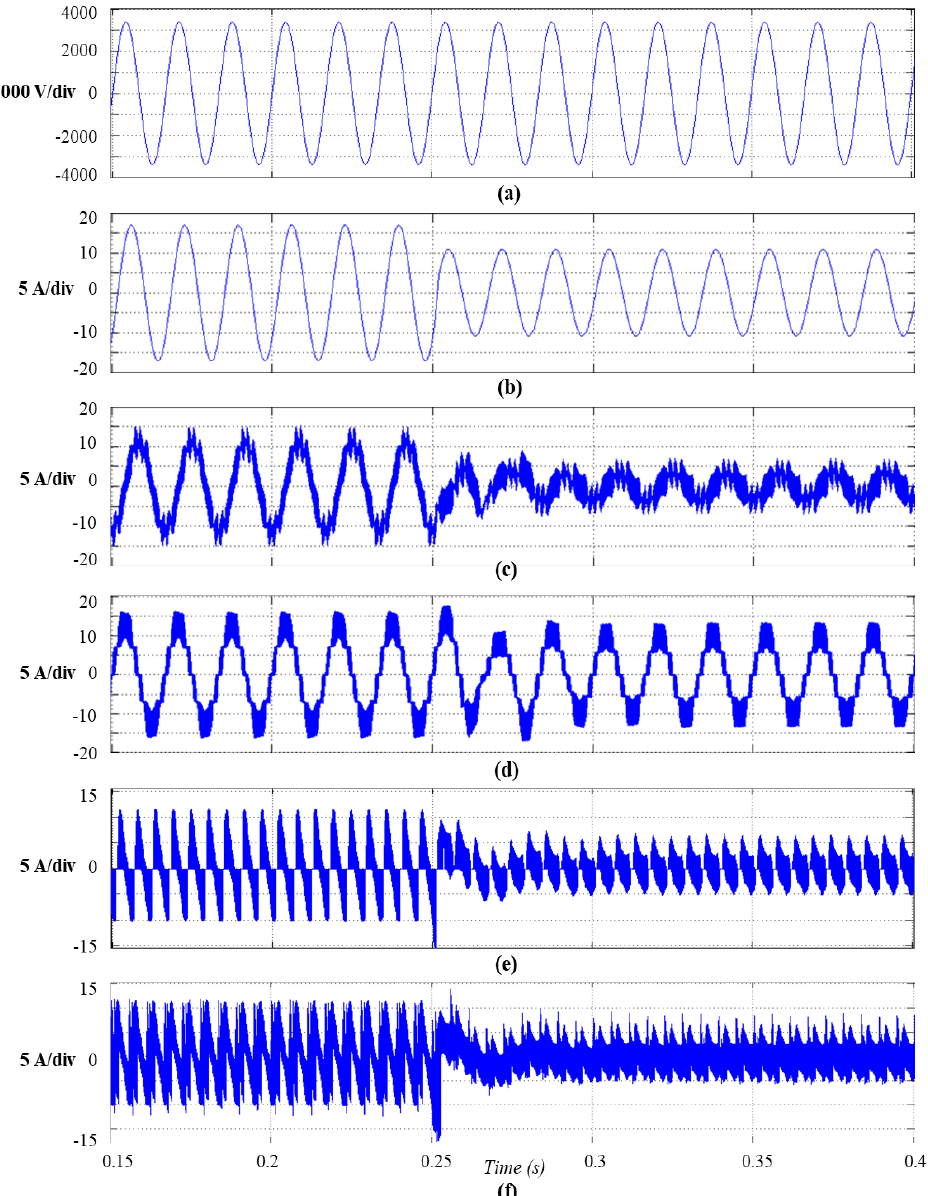
Figure 10. Simulation waveforms of the proposed five-level STATCOM with the multilevel OCC control. ( a ) Grid phase voltage ( V A ); ( b ) Load current ( i LA ); ( c ) STATCOM current ( i CA ); ( d ) Grid phase current ( i GA ); ( e ) First upper dc-link capacitor current ( i C 1 ); ( f ) Second upper dc-link capacitor current ( i C 2